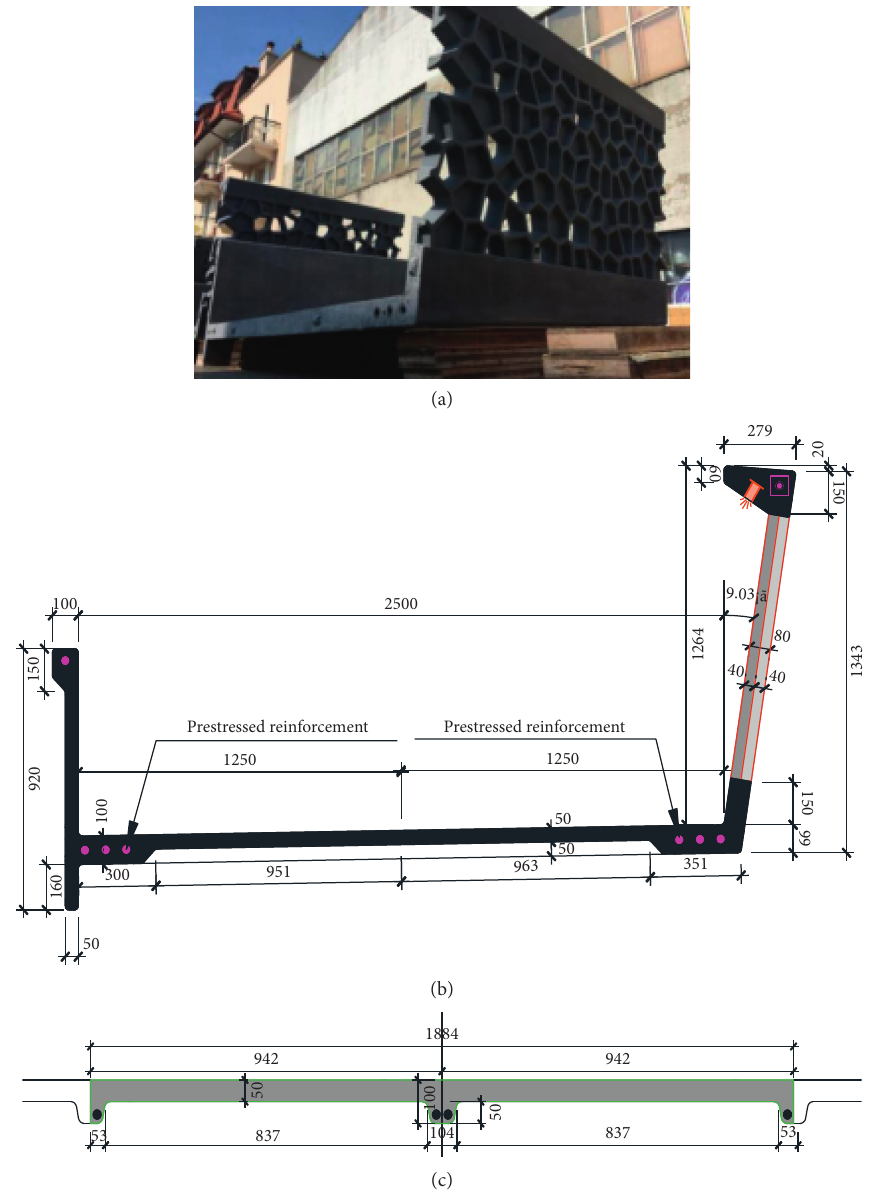
Figure 1: Full-scale model construction of the U beam. (a) Test component of U beam. (b) Cross-section (unit: mm). (c) Longitudinal section (unit: